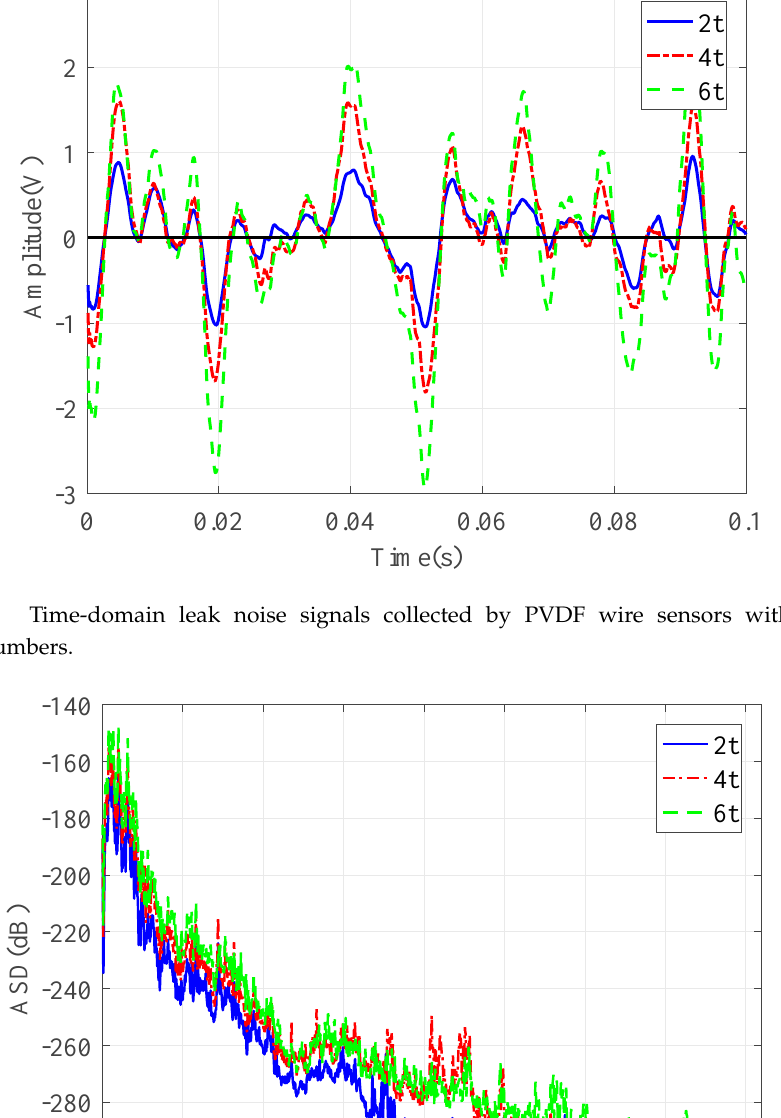
Figure 9. Auto-spectral densities (ASDs) of the leak noise signals collected by the PVDF wire sensor with 2t and hydrophone.